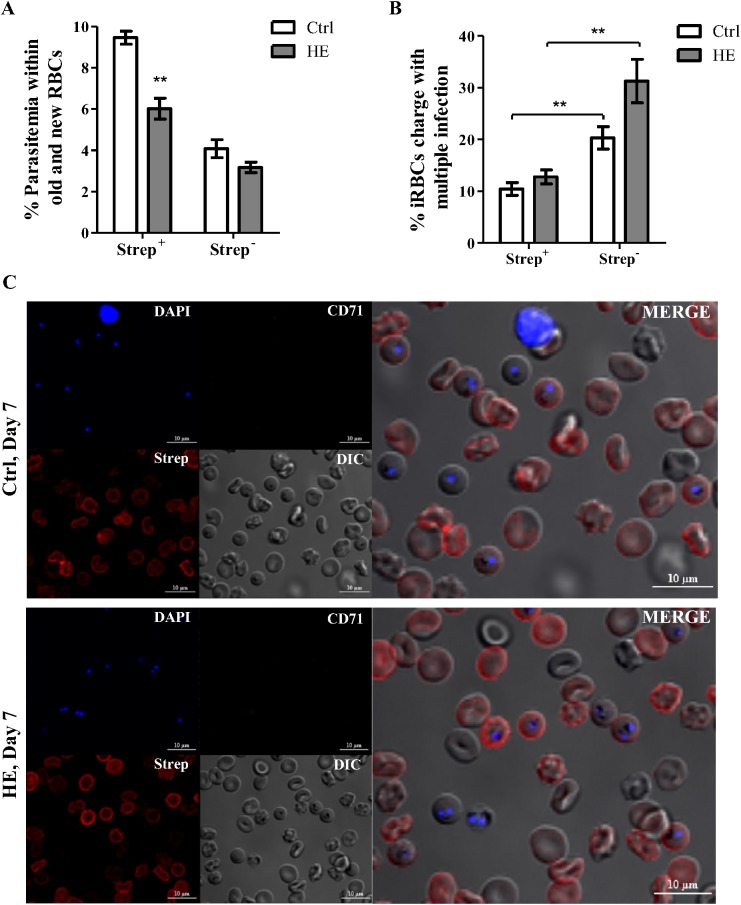

Plasmodium chabaudi adami parasites preferentially infect RBCs that have not been conditioned by HE.At peak parasitemia (day 7 post-infection), whole blood was fixed in 1% paraformaldehyde overnight, washed, stained and analyse with confocal microscopy. The parasites were labeled with DAPI (blue), and distinction between saline/HE-treated RBCs (strep+) and RBCs generated after treatments (strep-) was made by APC-conjugated streptavidin staining (red): reticulocytes were stained with FITC-labeled anti-CD71 antibody (green). DIC and fluorescence images were captured with Nikon A1 confocal microscope (plan Apo VC 60x, NA 1.4, λs oil immersion), and analysed with NIS-Elements Viewer 4.20 imaging software. Parasitemia within strep+ and strep- RBCs (A; infected strep+/- RBCs / total strep+/- RBCs) and proportions of strep+ and strep- RBCs charge with multiple ring (B; multiple infected strep+/- RBCs / infected strep+/- RBCs) were evaluated on >150 ring-iRBCs per mouse. DAPI, anti-CD71-FITC, streptavidin-APC fluorescence, DIC and merged channels are shown for a control and a HE-treated mouse (C). Data are the means ± SEM of one experiment (n = 4). All data from Ctrl and HE-treated mice were compared with an unpaired Student t test, **p<0.01, (Fig 5B; Ctrl strep- vs HE strep-, p = 0.0593).